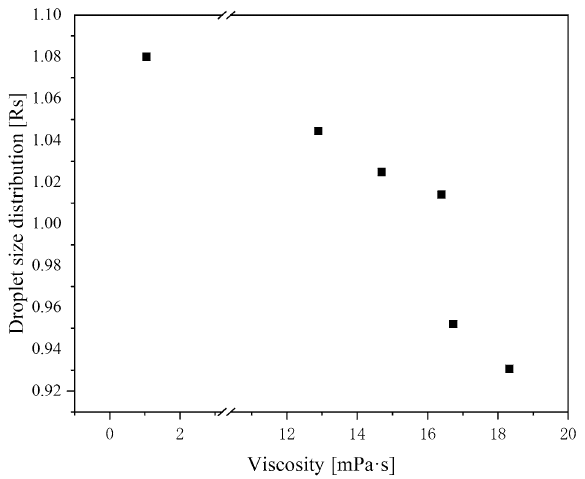
Figure 8. Relationship between formulation viscosity and droplet spectrum. The detailed data of drawing the figure is shown in Supplementary Table S7.